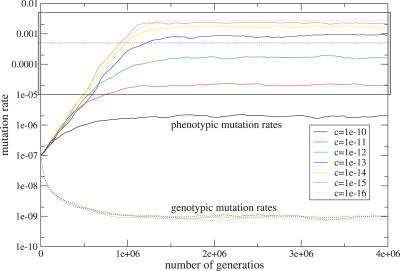
Evolving Phenotypic and Genotypic Mutation RatesThe evolution of phenotypic (solid lines) and genotypic (dotted lines) mutation rates is shown. For each of seven different values for the cost of erroneous proteins, c, we conducted ten simulation runs and calculated an average evolutionary trajectory (see text for more details). As expected, only the phenotypic mutation rate is affected by changes in c. Near u = 2 × 10−3 we observe an upper limit for the phenotypic mutation rate. Even large changes in c affect the phenotypic mutation rate only marginally (compare grey and brown lines). This (effective) upper bound for u is the result of a rapid, nonlinear increase in abnormal proteins as a function of u (see Figure 2). The (grey) box indicates the possible range of phenotypic mutation rates (1 × 10−5 – 5 × 10−3, according to Parker [5]) with 5 × 10−4 (dashed line) as a commonly used estimate for the global error rate.